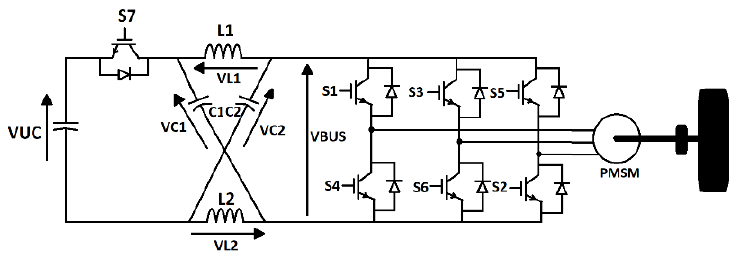
Figure 2. 3-phase Z-source inverter.